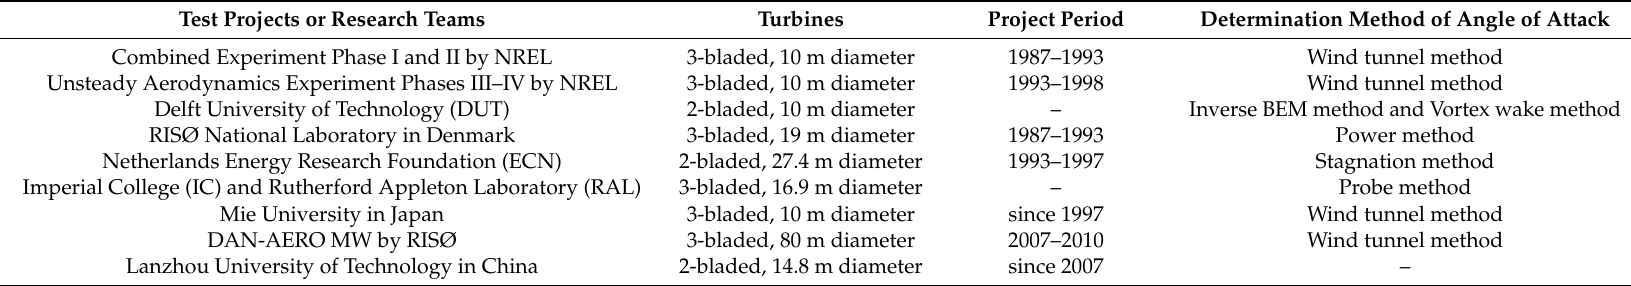
Table 1. The existing work on aerodynamic measurement in the